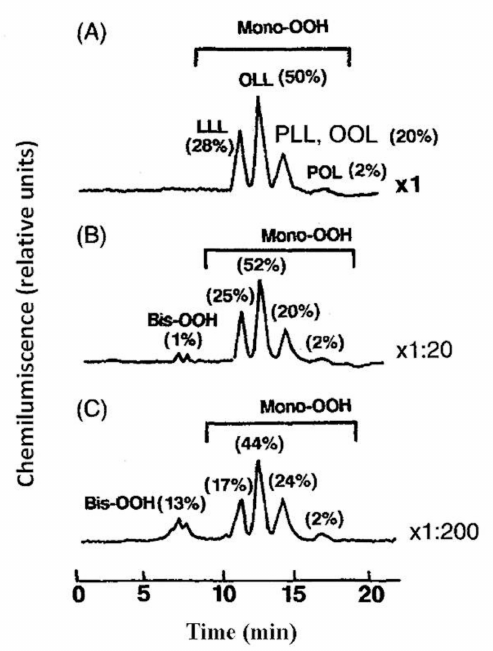
Figure 10. Chromatograms of chemiluminescence-detection high-performance liquid chromatog- raphy (CL-HPLC) of soybean oil (( A ), peroxide value [PV] = 6 meq/kg; ( B ), PV = 110 meq/kg; ( C ), PV = 780 meq/kg) autoxidized at 25 ◦ C. × 1, × 1:20, × 1:200, indicate the relative dilution ratios of oxidized oil. Trilinoleoylglycerol (LLL), oleoyl-linoleoyl-linoleoylglycero (OLL), palmitoyl-linoleoyl- linoleoylglycerol (PLL), oleoyl-oleoyl-linoleoylglycero (OOL), and palmitoyl-oleoyl-linoleoylglycerol (POL) depict the fatty-acid combination in the molecular species of triacylglycerol. Adopted with permission from [67]. Copyright 1995,